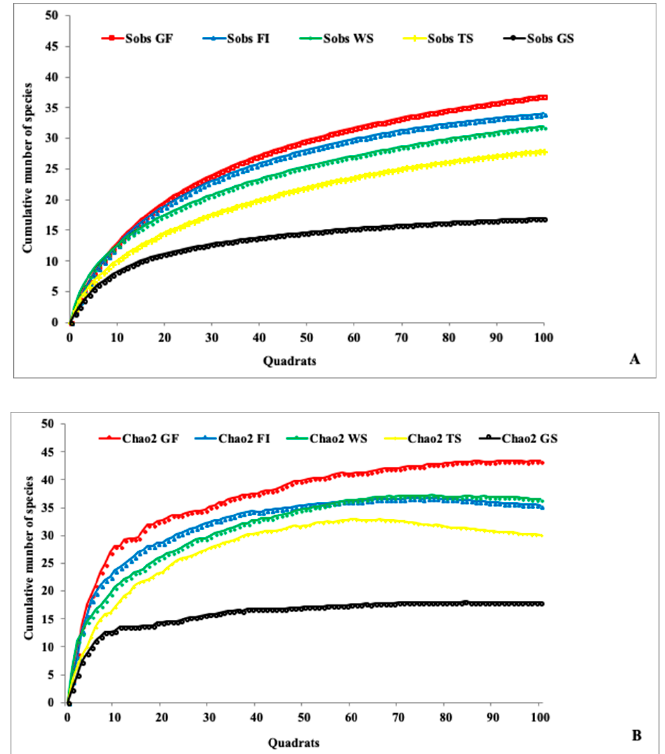
Figure 1. Accumulation curves of the observed ( A ) and estimated species richness ( B ) in the visited habitats. Table 2. Dissimilarity assessment of termite assemblages between the visited habitats.